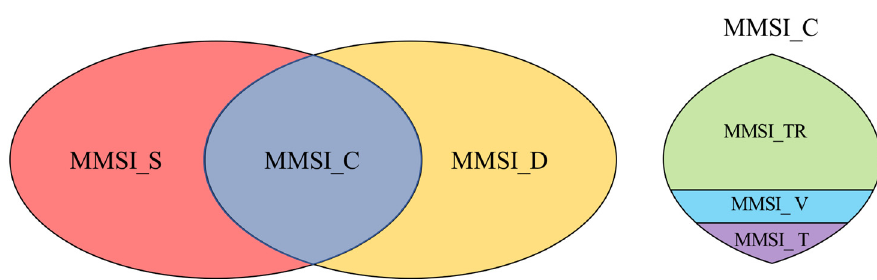
Figure 9. Split the datasets by MMSI. For a trajectory T i m , if i m in MMSI_C, we can generate one DFD i m , n TS i m n , and n TSF i m n , which corresponds to one s i m . The number of static samples and dynamic samples with the same MMSI is different. To solve this problem, we copy DFD i m and s i m n times in DFD and SF ,